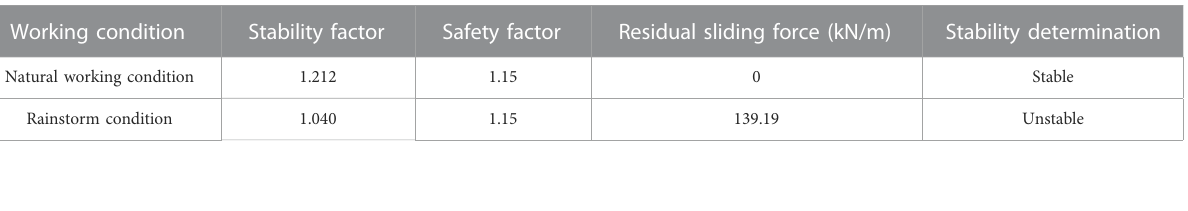
TABLE 2 Stability calculation results of transfer coef fi cient method.